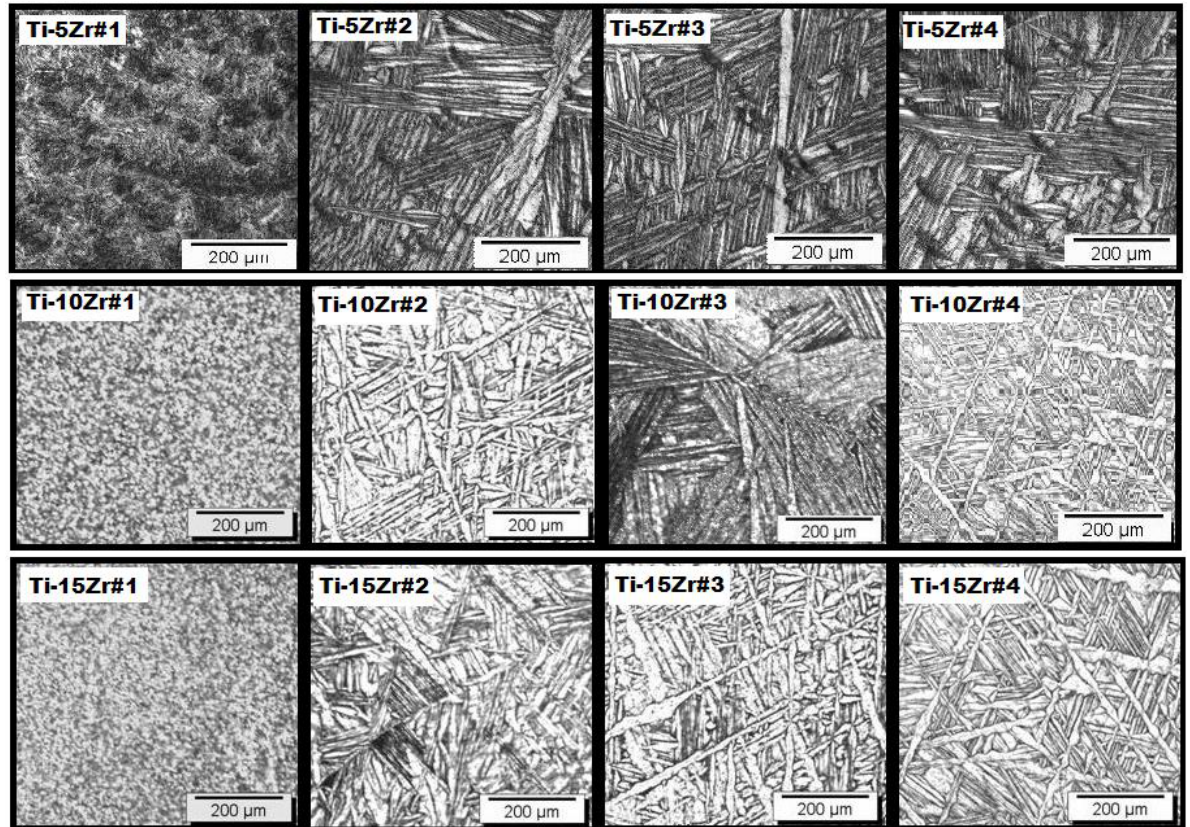
Figure 3. Optical micrographs for Ti-Zr alloys.